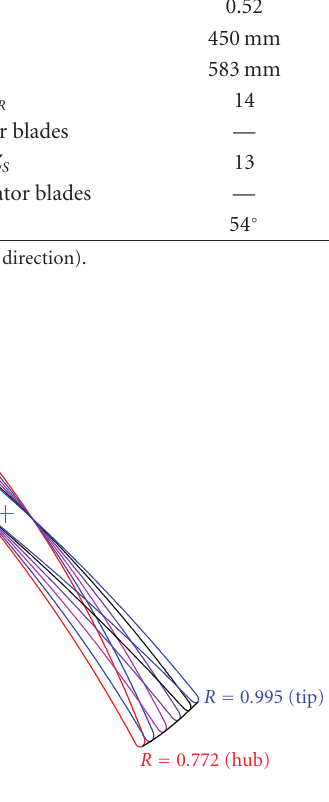
Figure 2: Rotor blade profiles at various radial stations.